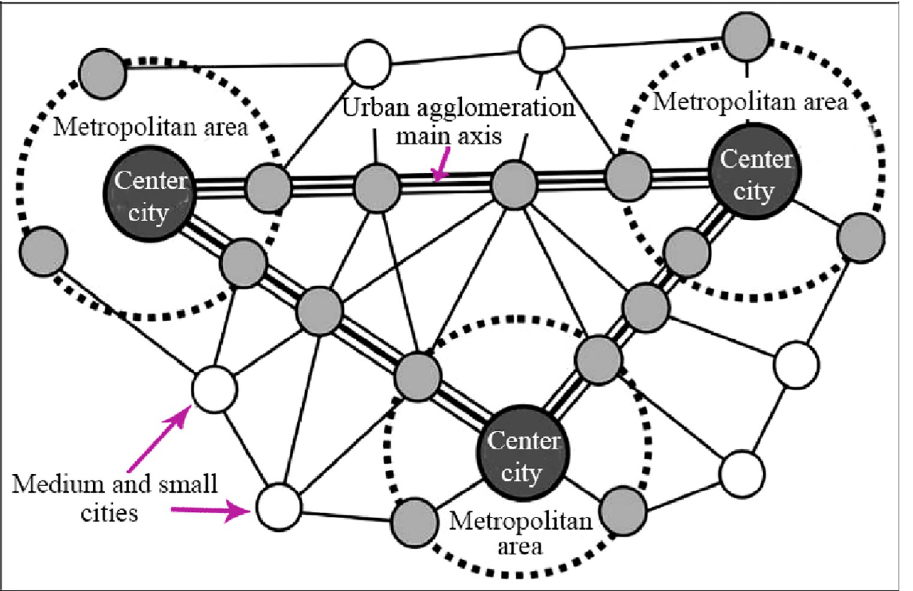
Fig 1. Urban agglomeration and metropolitan coordinating region